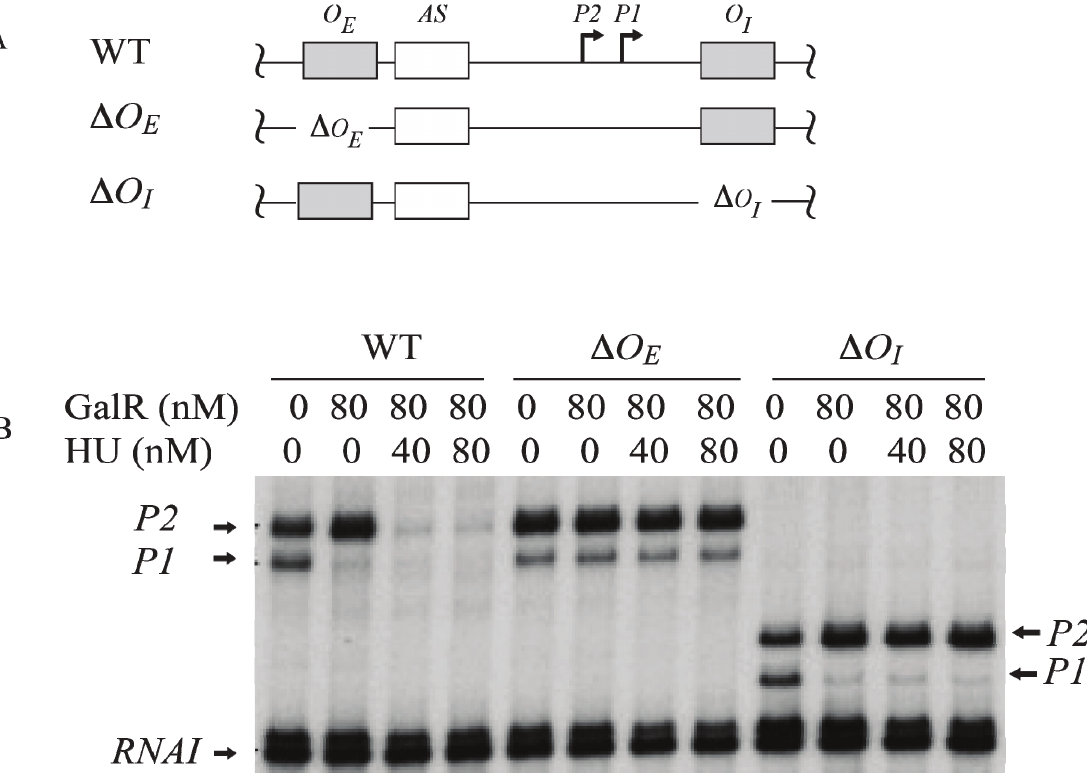
Figure 6. Role of the operators in the transcription regulation of gal promoters. ( A ) Templates showing (cid:6) O E and (cid:6) O I deletions; ( B ) mRNAs made from P1 and P2 on O E and O I , (cid:6) O E and O I , and O E and (cid:6) O I templates in the presence of GalR (80 nM) and HU (40 nM, 80 nM) (adapted from